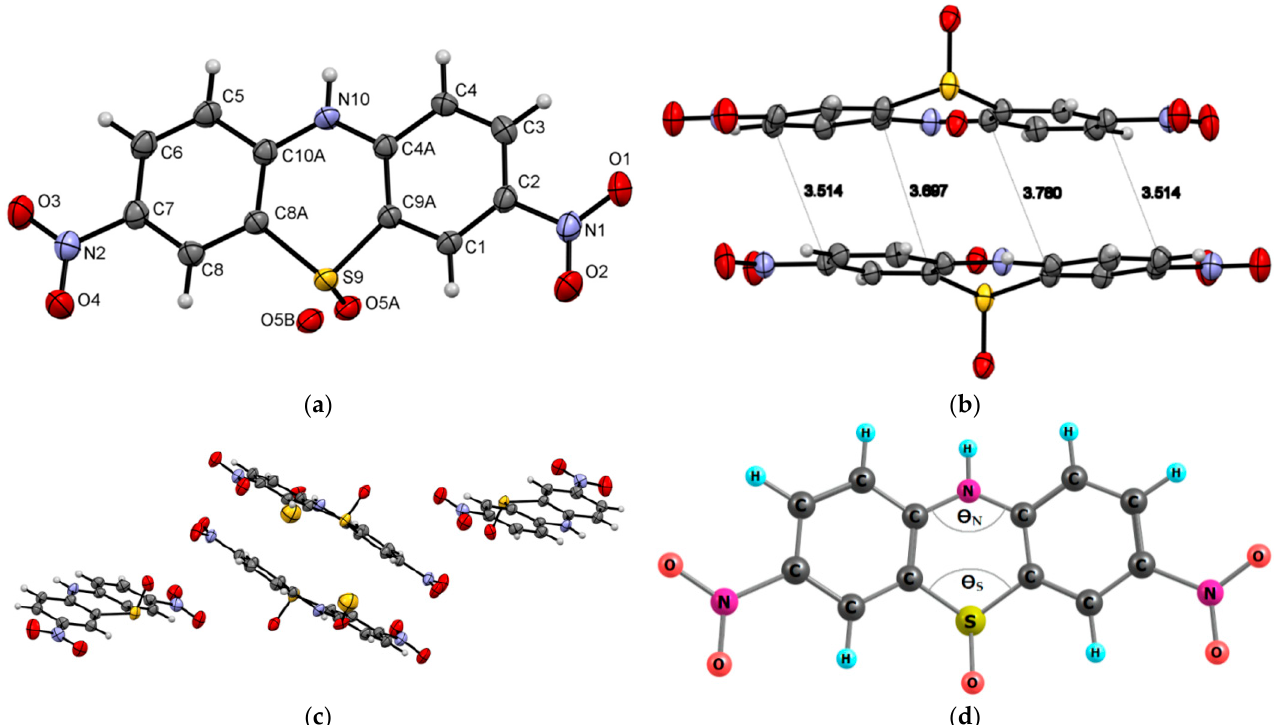
Figure 3. ORTEP diagram of 3,7-dinitro-10 H -phenothiazine 5-oxide ( 3 ) with 50% probability. Top view ( a ), packing ( b , c ) and structure with denoted bending angles in the middle phenothiazine ring Θ S and Θ N ( d ).